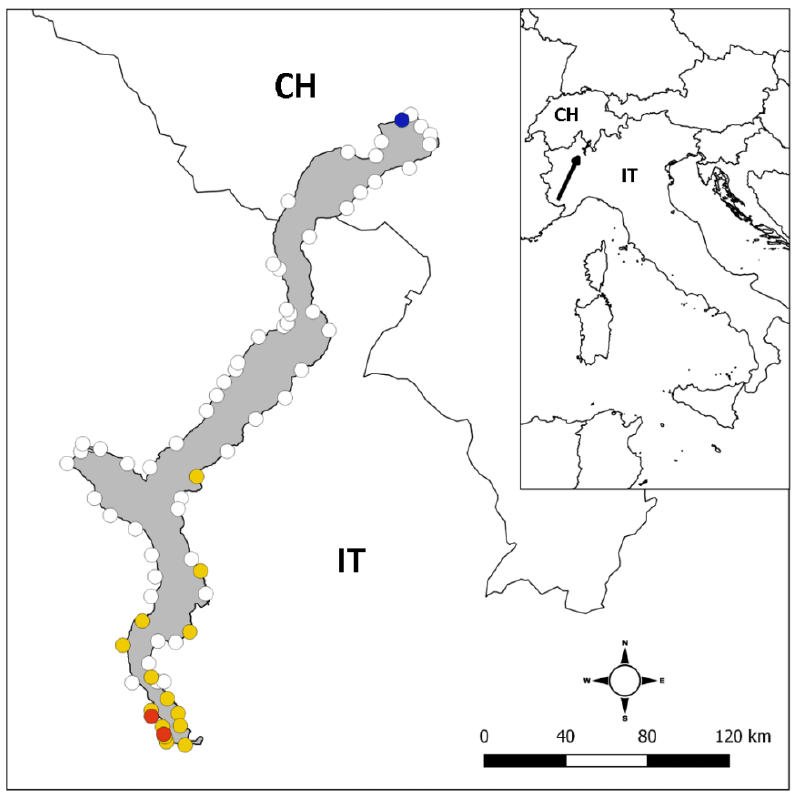
Figure 1. Sampling sites (dots) across Lake Maggiore (IT: Italy, CH: Switzerland). Red dots: sites of occurrence of Procambarus clarkii ; Yellow dots: Orconectes limosus ; Blue dot: Pacifastacus leniusculus ; White dots: no alien crayfish detected.